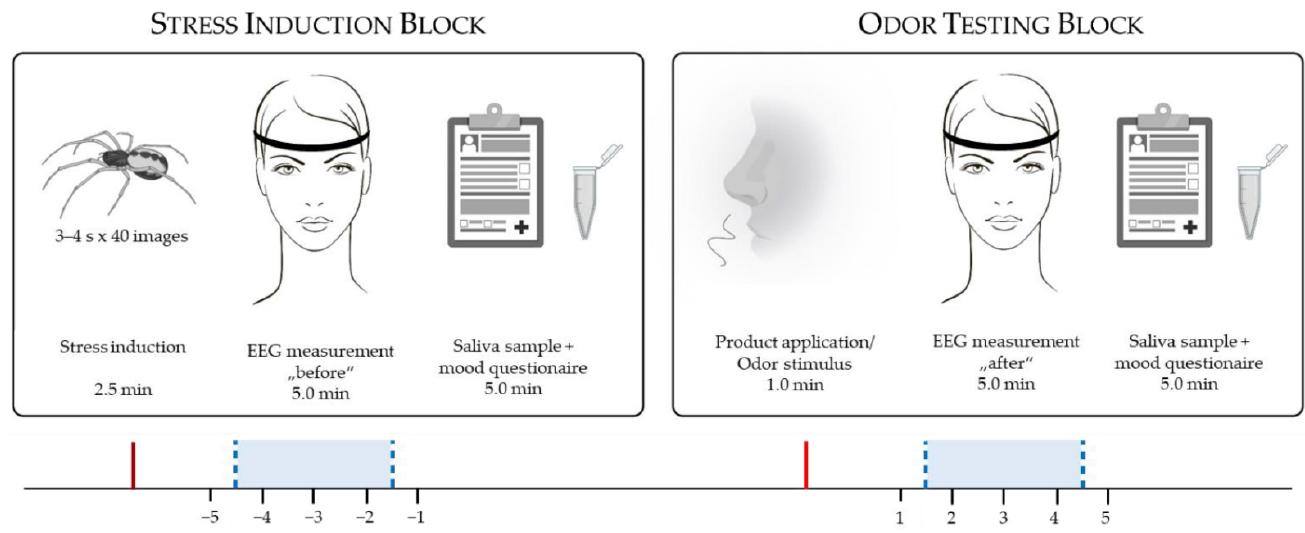
Figure 1. Experimental paradigm for stress induction and product testing